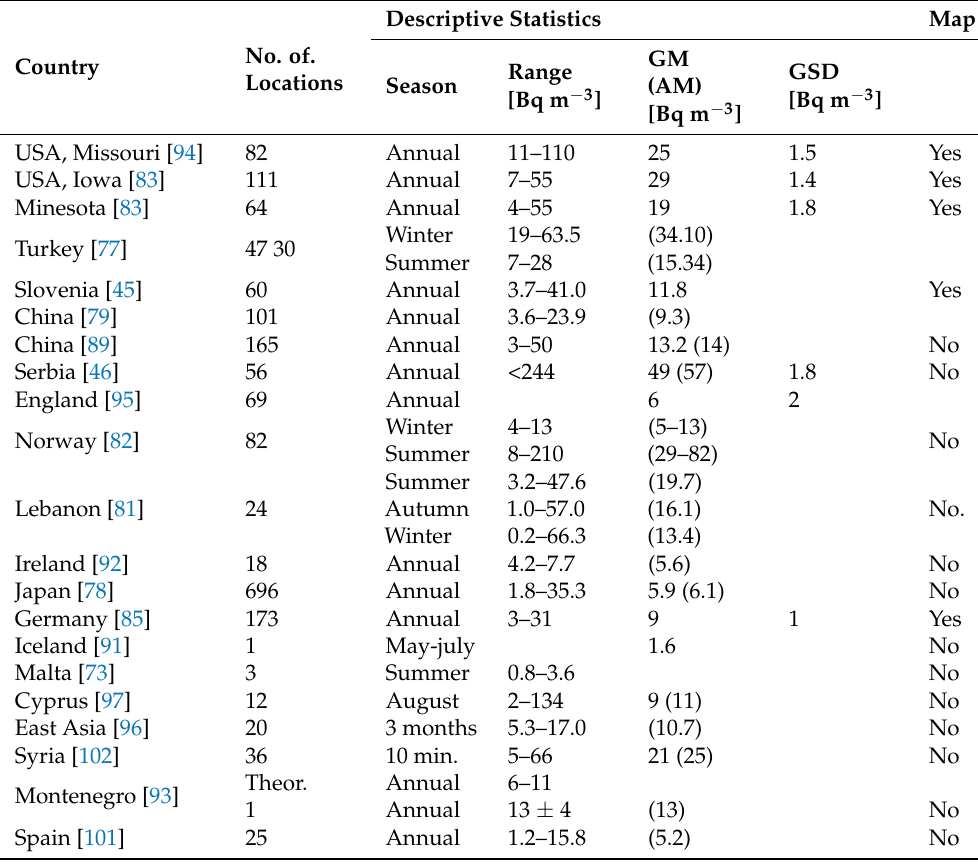
Table 2. A descriptive statistics (range of measured concentrations (Range), geometric mean (GM), arithmetic mean (AM) and standard deviation (GSD)) of outdoor radon survey.